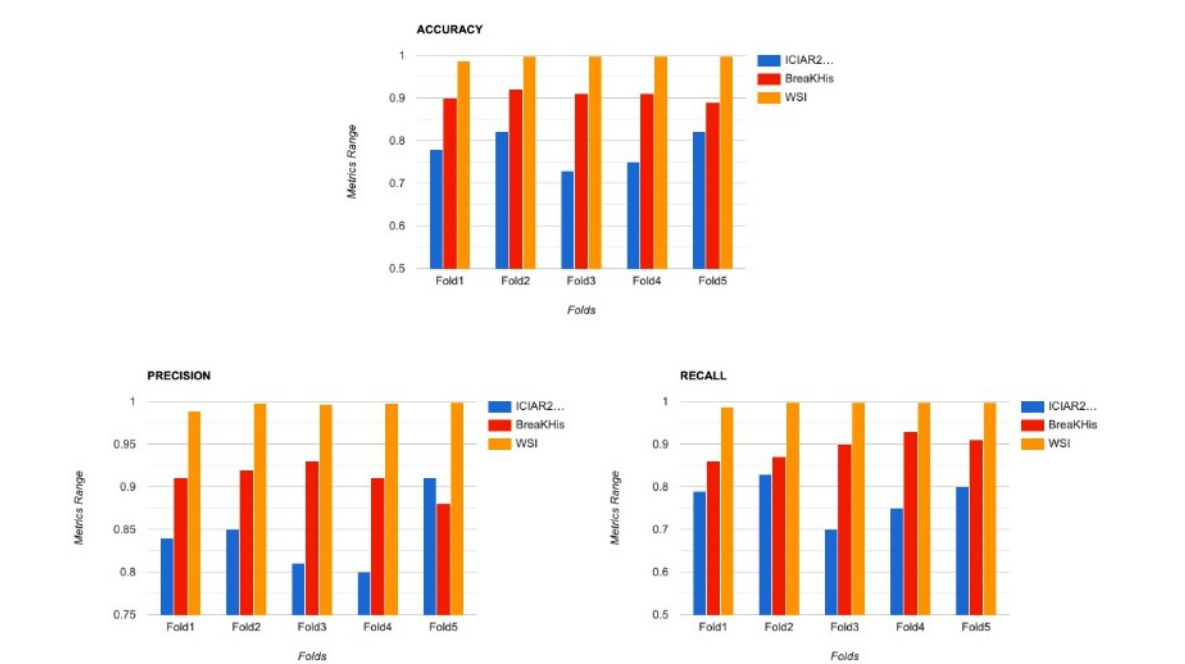
Figure 6. Comparison of performance metrics for WSI(O), BreaKHis(R), and ICIAR2018(B) Datasets. The proposed work was further tested on another dataset popularly known as ICIAR2018 Dataset. The dataset is sourced from [35]. This dataset contains data from four different types of Breast Cancer. However for this study, only Benign and InSitu Invasive data points were considered. There were a total of 400 images, out of which only 200 were used for training. In order to get a good accuracy, data augmentation was done on the images. The results on this dataset are also plotted in Figure 7.